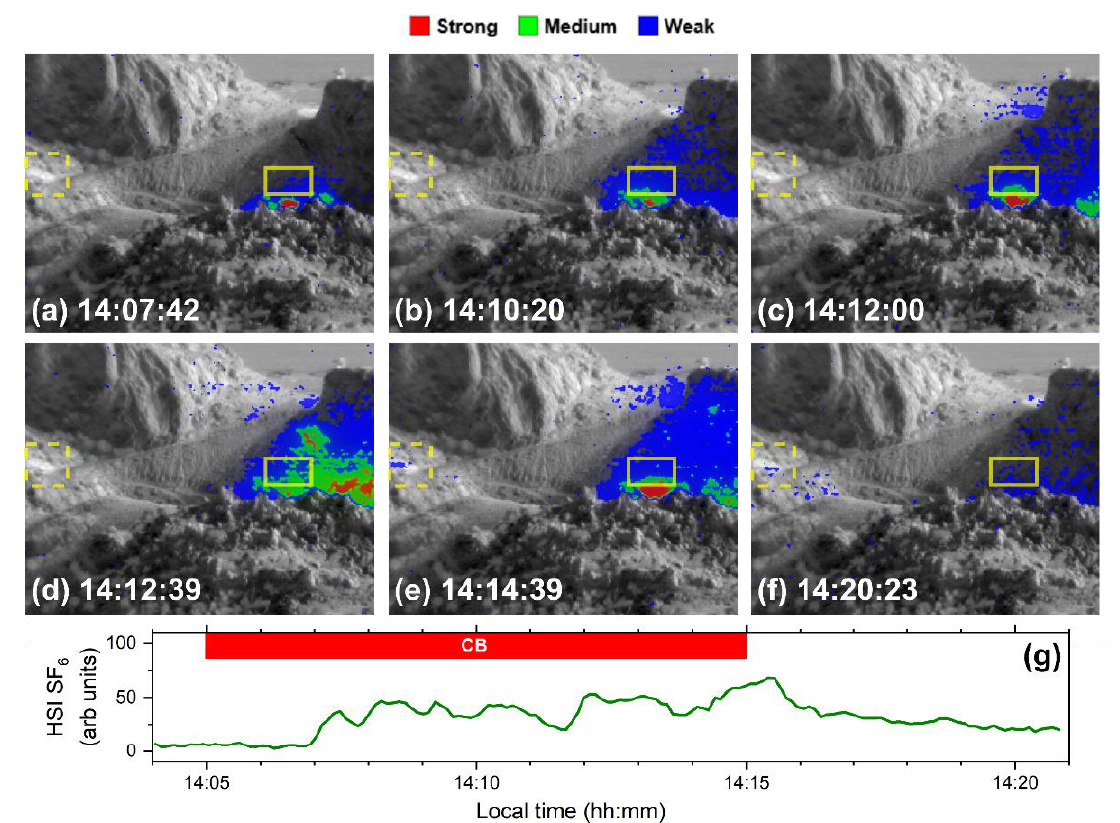
Figure 5. Plume detection using an LWIR-HSI system during a release of SF 6 from the CB location. ( a – f ) Images of detected SF 6 at selected local times (hh:mm:ss). The dashed box shows the location of the retroreflector. Color mapping blue (weak), green (medium), and red (strong) shows the relative HSI absorption signal strength between zero and maximum, divided into three equal bins. ( g ) SF 6 signal versus time averaged over the region in the solid yellow box. The solid red bar shows the times over which SF 6 was released.